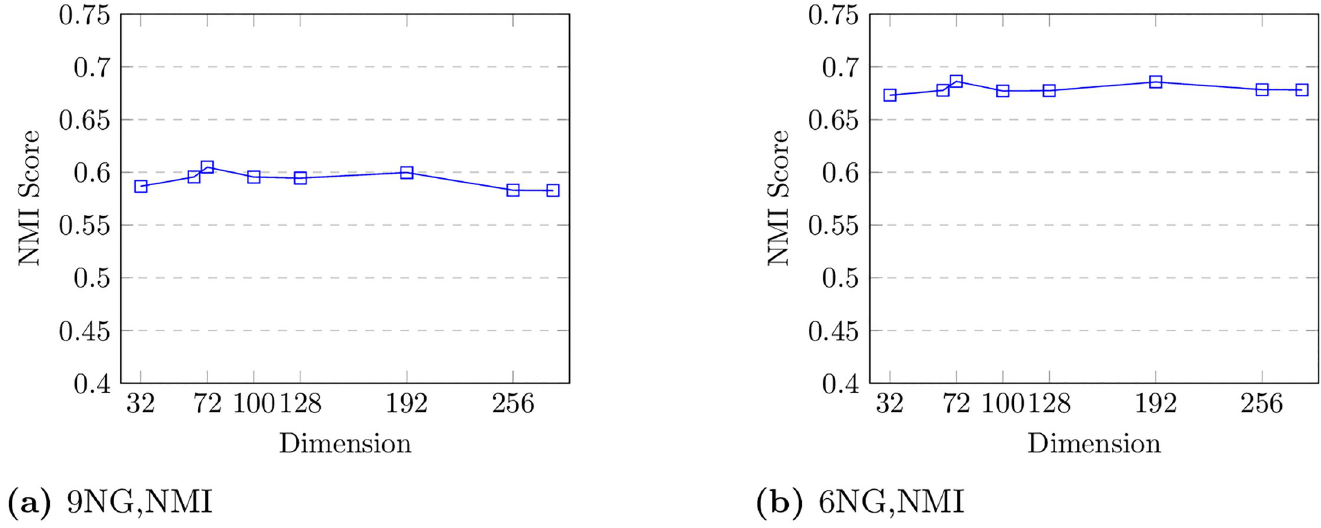
Fig 4. Performance of SimNet over different dimensions.